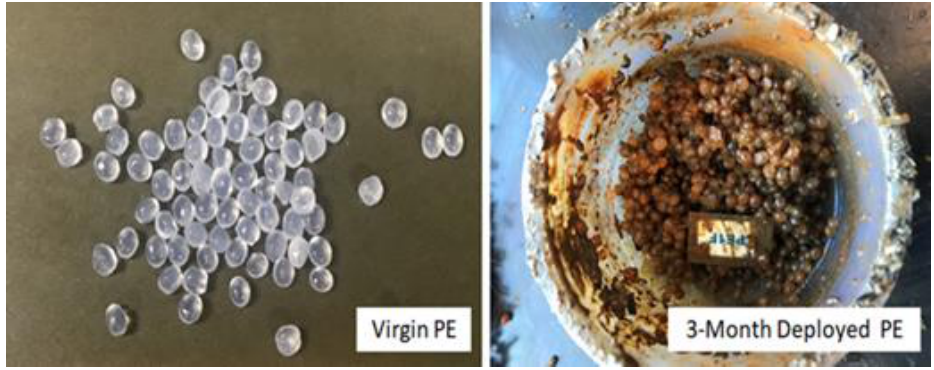
Figure 7. Low Density Polyethylene Before and After Deployment in Muskegon Lake, MI. Although microplastics were found to significantly concentrate PFASs from back- ground environmental concentrations, on a per mass basis they are relatively low. In the worst-case scenario found here (polyethylene/channel bottom/3 month duration), the highest concentration of microplastic-associated PFAS was 0.87 ng/g (lowest: 0.052 ng/g). Therefore, for every gram of plastic consumed there exists the potential for an organism to be exposed to an additional ~1 ng of common PFAS. However, it should be noted